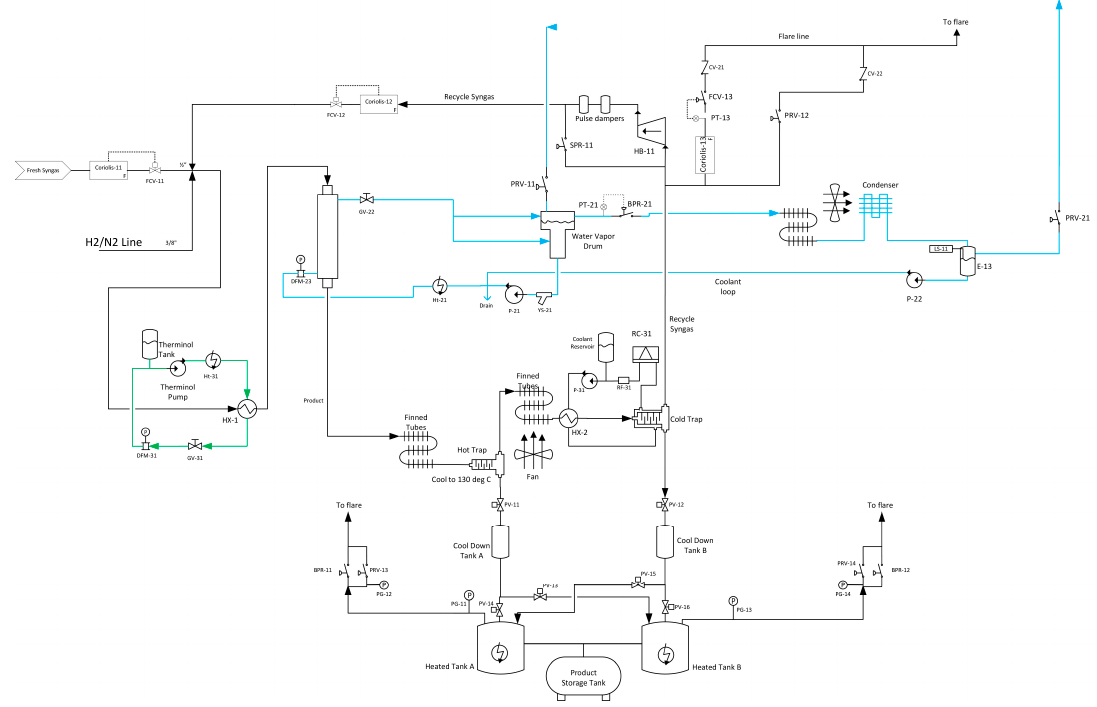
Figure 4. OxEon Energy commercial-scale fixed-bed reactor prototype process flow